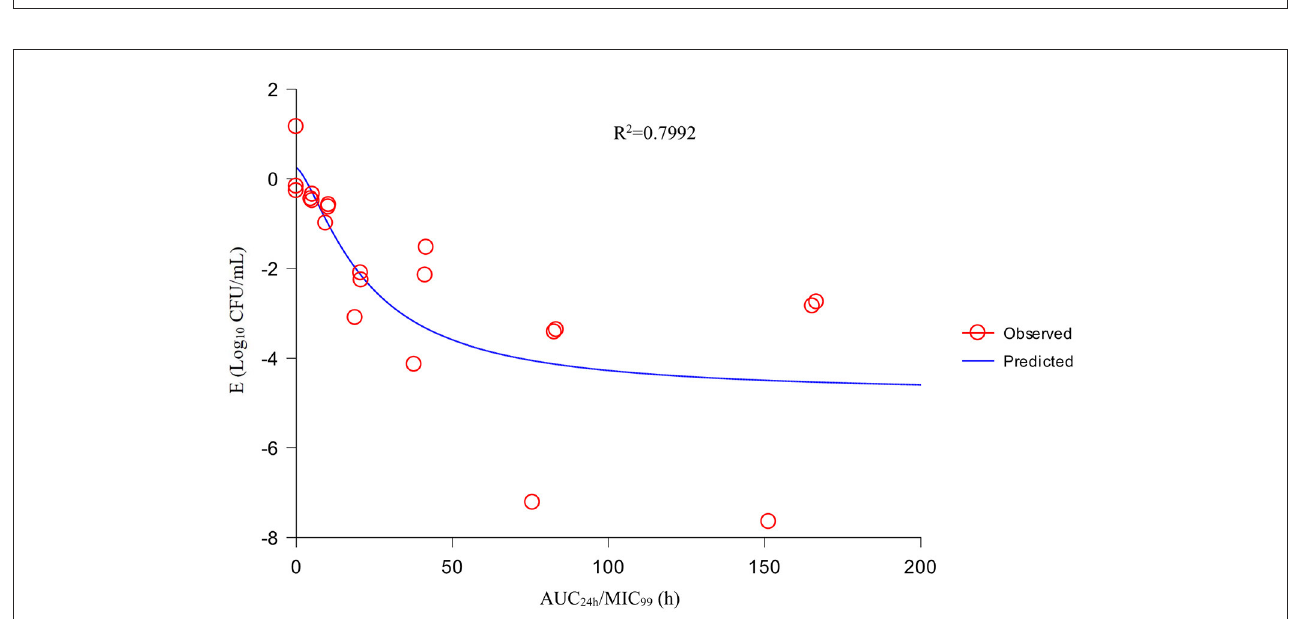
FIGURE4 Fitting curve between AUC 24h /MIC 99 and the antibacterial